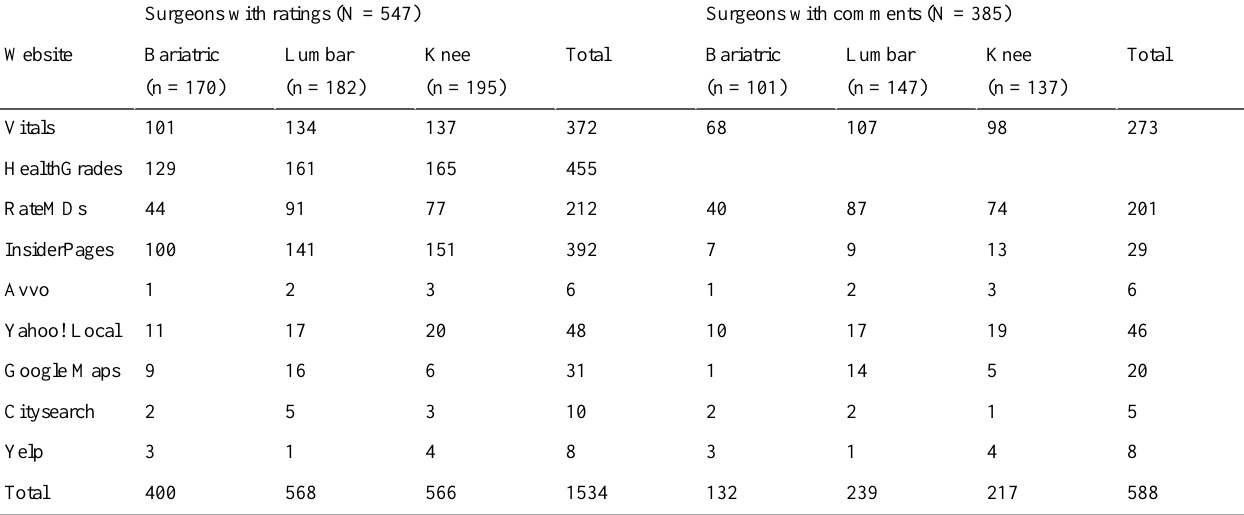
Table 5. Numbers of surgeons with ratings and comments posted on a study website.